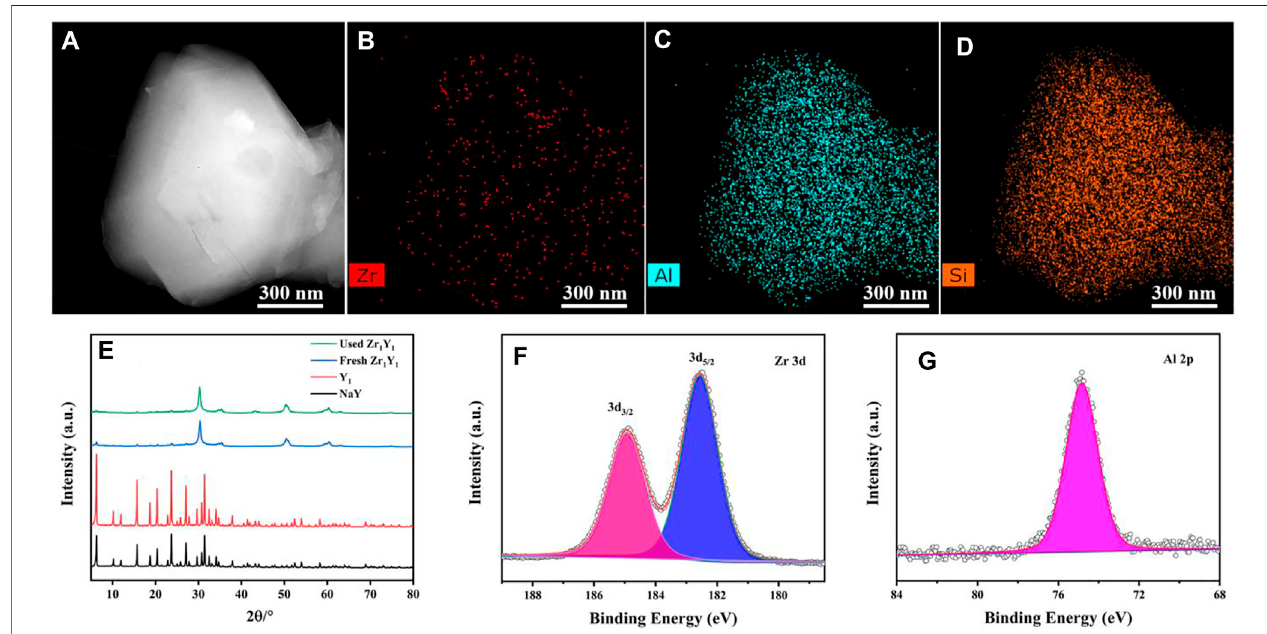
FIGURE 1 | TEM images of Zr 1 Y 1 catalyst (A) , corresponding EDS mapping patterns (B – D) , XRD patterns of different samples (E) , XPS spectra of the Zr 1 Y 1 catalyst (F) , Zr 3d, and (G) Al 2p.